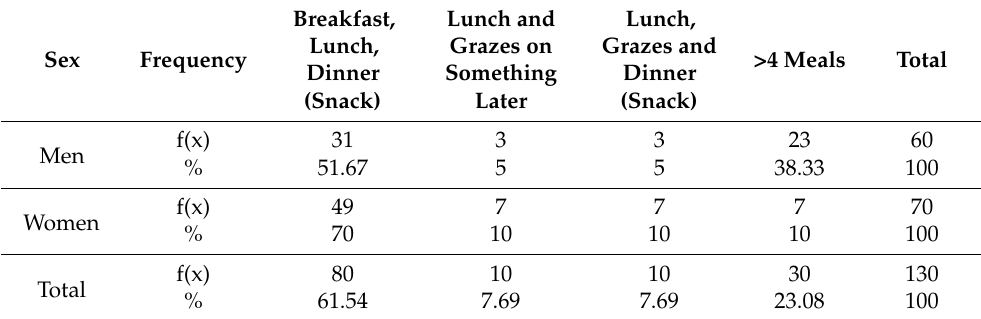
Table 6. Distribution of participating older adults according to feeding times.